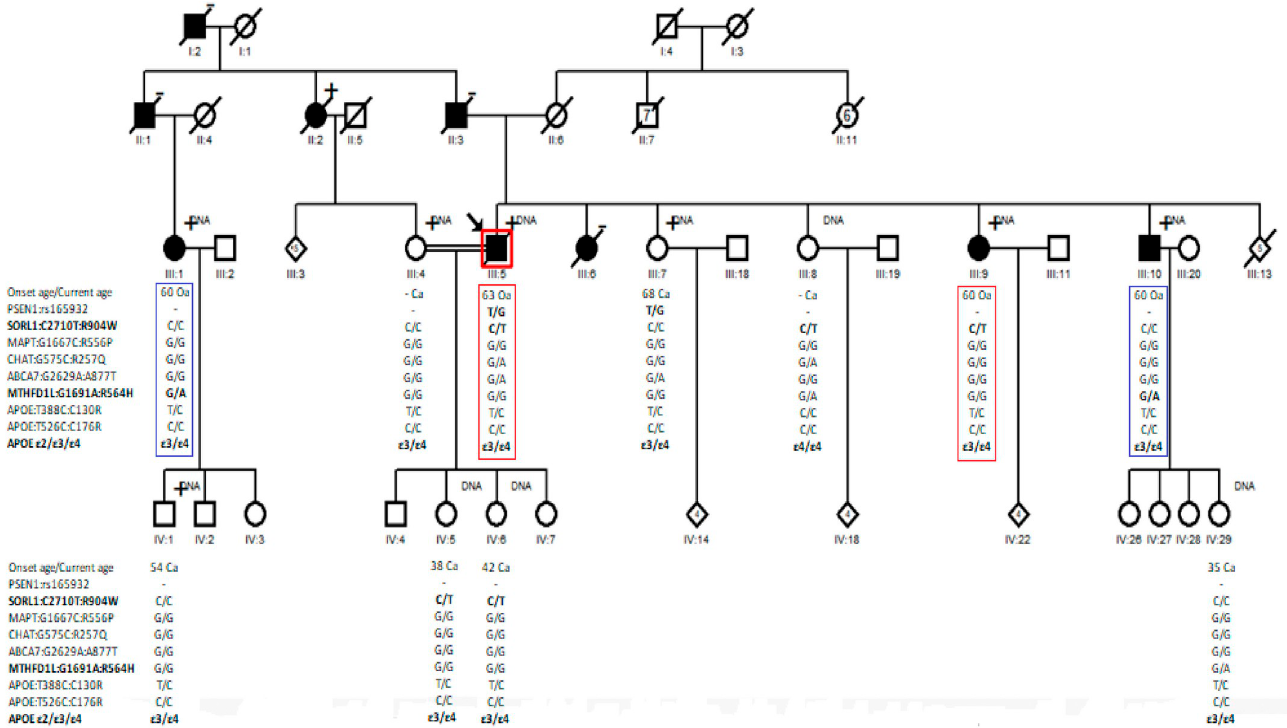
Fig 2. Reduce pedigree of AD family with SORL1:c.C2710T:p.R904W, MAPT:c.G1667C:p.R556P, CHAT:c.G770A:p.R257Q, ABCA7:c.G2629A:p.A877T, MTHFD1L:c.G1691A:p.R564H, APOE:c.T388C:p.C130R and APOE:c.T526C:p.C176R variants suggesting an oligogenic inheritance. Squares : Males. Circles : Female. Filled symbols : Affected family members. Empty symbols : Non-affected family members. DNA : Indicates family members with DNA samples. + symbol : Indicate family members with neurological evaluation. Oa : Onset age. Ca : Current age. Red dotted line : Affected family members carrying the R904W variant in SORL1 gene. Blue dotted line : Affected family members carrying the R564H variant in MTHFD1L gene.